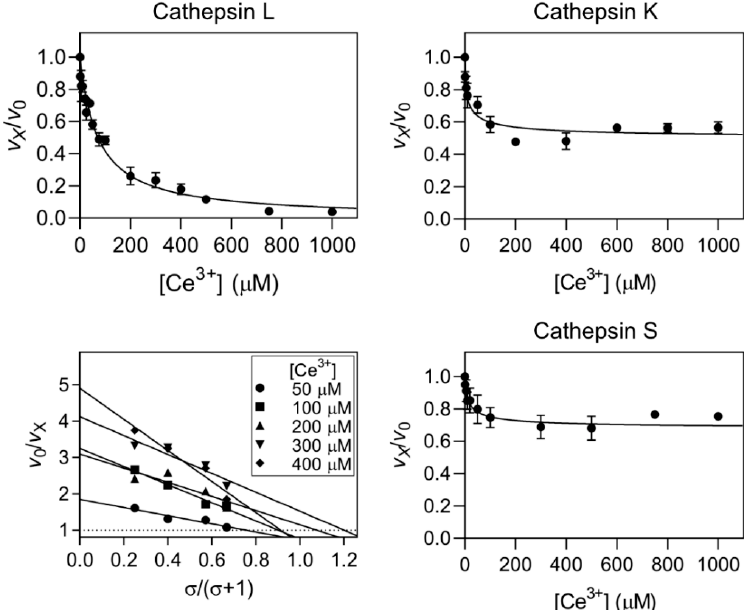
Figure 4. Inhibition of cathepsins L, K, and S by Ce 4+ ions. The titration curves are shown in the upper panels and the specific velocity plots used to determine the inhibition mechanisms are shown in the lower panels. Activity was measured with synthetic fluorogenic substrates (Z-Leu-Arg-AMC, Z-Phe-Arg-AMC and Z-Val-Val-Arg-AMC for cathepsins L, K, and S, respectively) at 25 °C in 0.1 M sodium acetate buffer pH 5.5. σ is equal to [S]/ K m . The error bars in the titration curves represent the S.E.M. of multiple independent experiments.